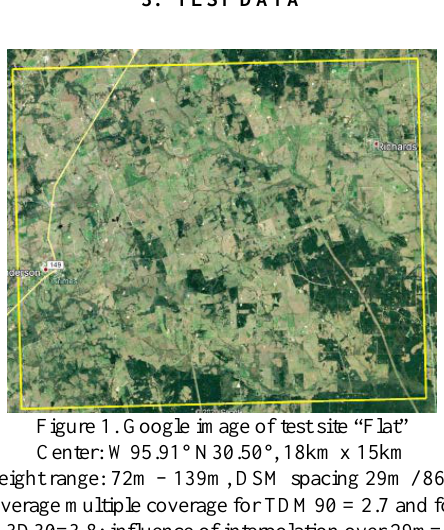
Figure 1. Google image of test site “Flat” Center: W95.91° N30.50°, 18km x 15km Height range: 72m – 139m, DSM spacing 29m / 86m Average multiple coverage for TDM90 = 2.7 and for AW3D30=3.8; influence of interpolation over 29m= 0.25m, over 86m= 0.53m (terrain